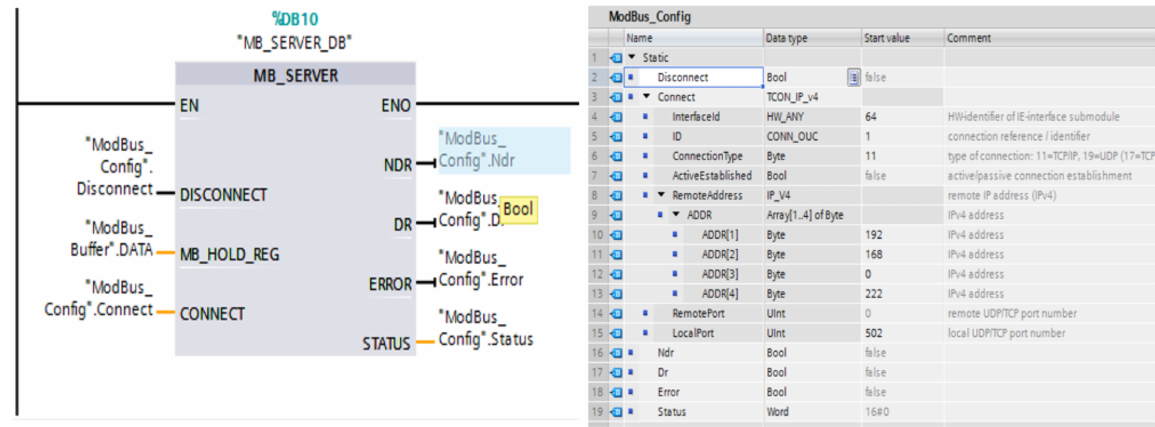
Figure 16. Siemens Modbus Server configuration in main